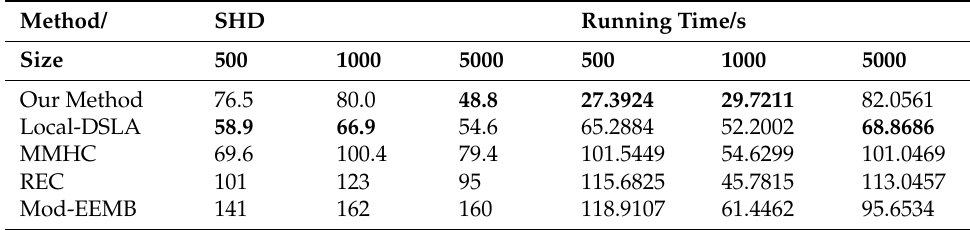
Table 4. Results for data